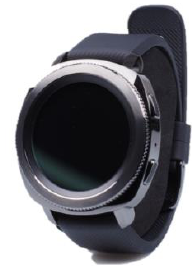
Figure 1. BLE beacons (kontakt.io smart Beacon) deployed in each room and the users’ Samsung Gear Sport smartwatch enable in-home room monitoring.